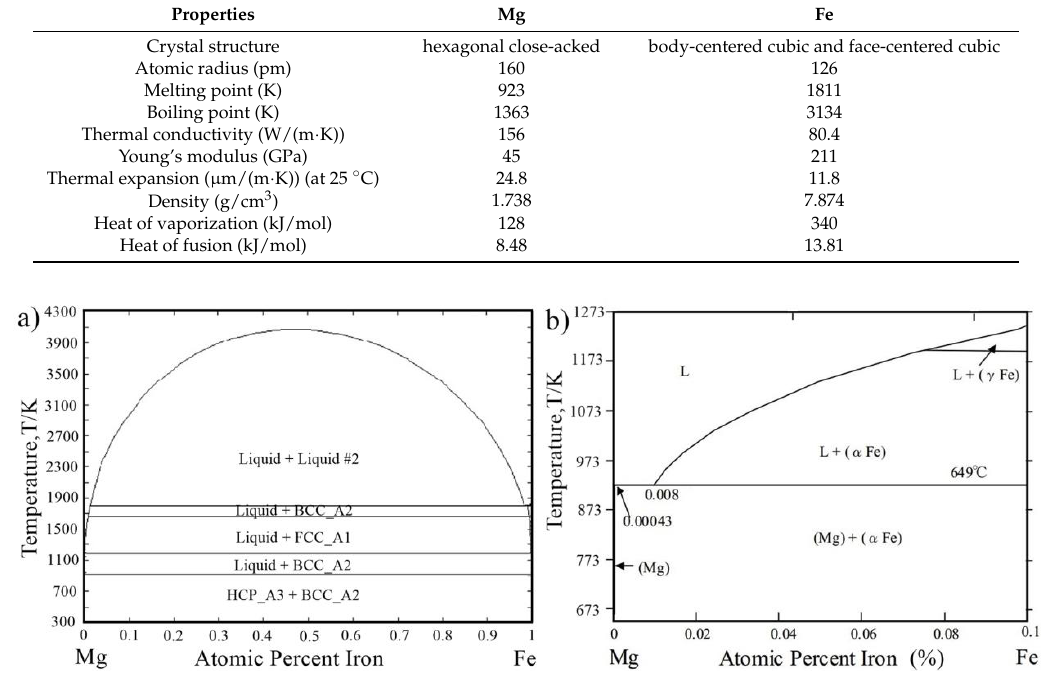
Figure 1. Mg-Fe binary phase diagram [9].